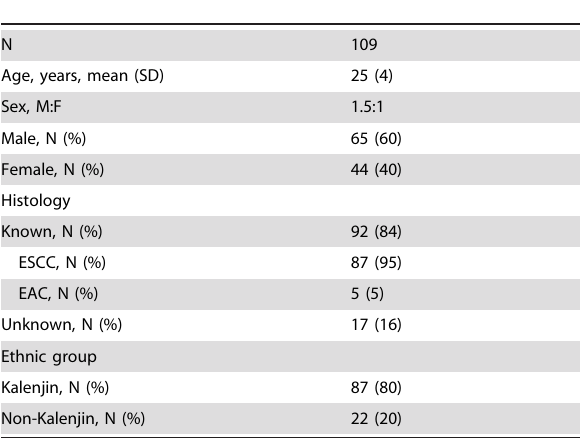
Table 1. Distributions of 109 esophageal cancer patients # 30 years of age seen at Tenwek Hospital from January 1996 through June 2009.